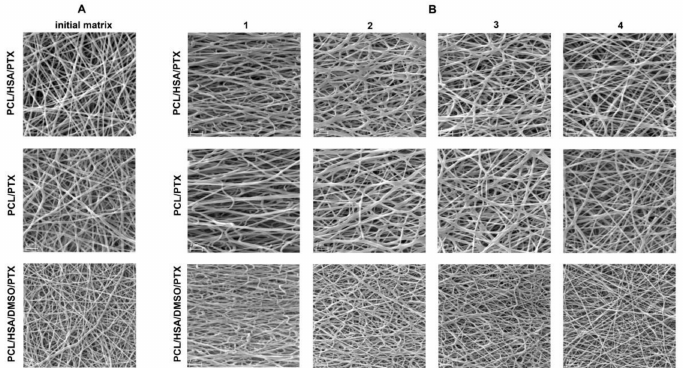
Figure 1. ( A ) SEM images of the intact matrices. ( B ) SEM images of different areas of the elongated matrices. The numbers represent the regions in the various positions of the elongated matrix (see Figure 2A).